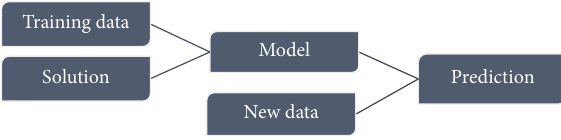
Figure 2: Flow chart of supervised machine